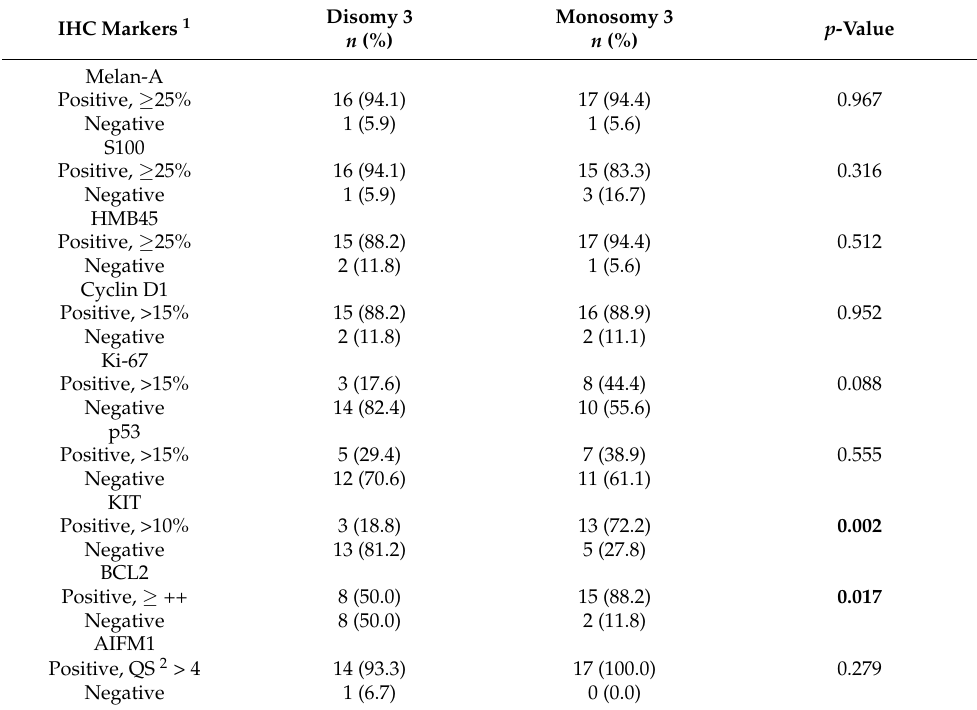
Table 4. Association between expression of studied proteins and Monosomy